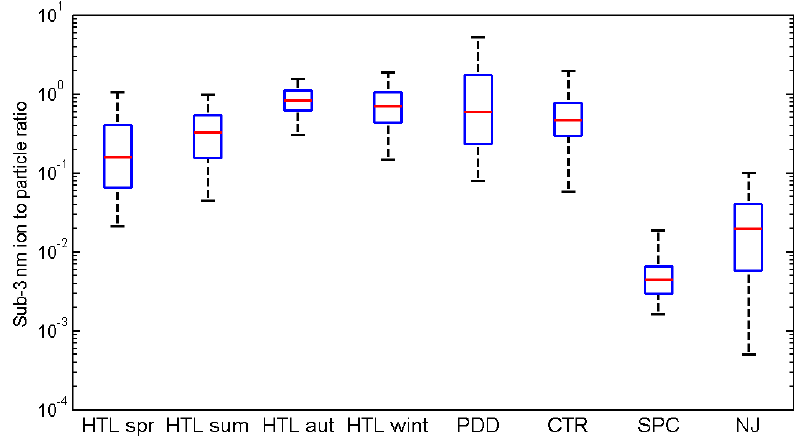
Figure 7. The ratio of sub-3nm ion concentration to the total particle concentration at different measurement sites. The red lines show the medians, the blue boxes indicate the 25th and 75th percentiles, and the vertical bars show the 5th and 95th percentiles. The data from Hyytiälä (HTL) are divided into different seasons: spring (spr), summer (sum), autumn (aut), and winter